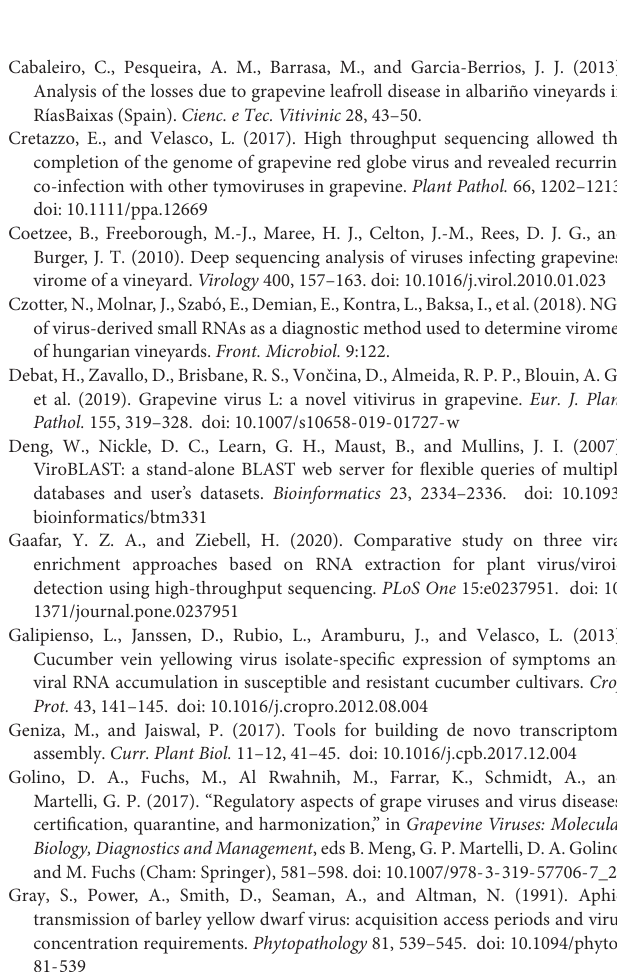
Supplementary Table 3 | Grapevine viruses and their GenBank numbers used as references in this study. Supplementary Table 4 | Number of vsiRNAs and genome coverage aligning to Grapevine yellow speckle viroid 1 and Hop stunt viroid 1 in the samples. Supplementary Table 5 | GenBank accession numbers of the sequences obtained in this study. Supplementary File 1 | Summary of the hits to viral sequences of the samples studied in this study after submission to Viruseq BLASTN and BLASTX using different k-mer